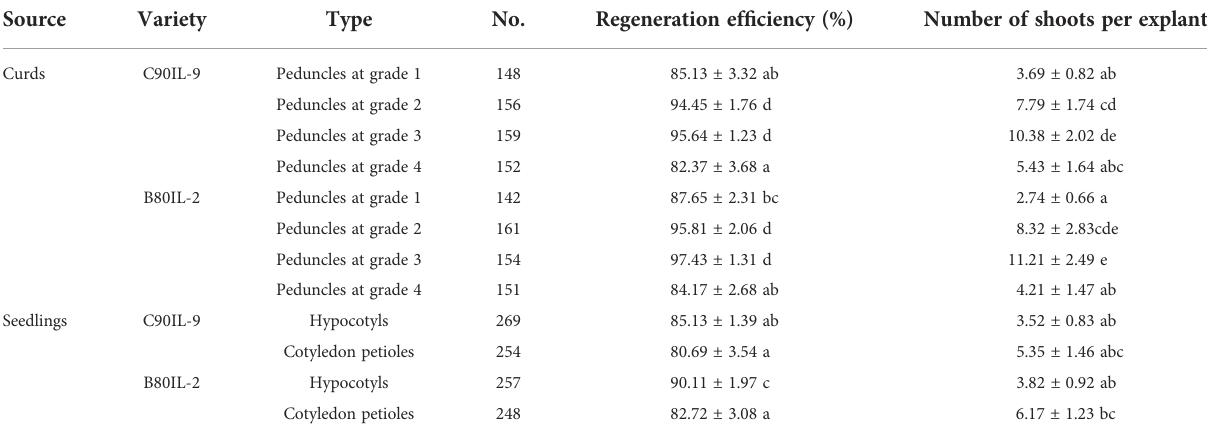
Different letters (a-e) after the levels of each factor indicate the statistically signi fi cant differences (P <